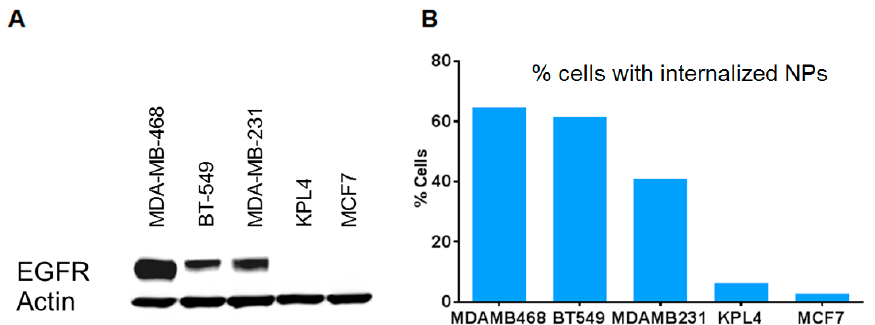
Figure 4. Specific uptake of cetuximab (anti-EGFR)-conjugated nanoparticles to EGFR+ vs. EGFR- breast cancer cells. ( A ) EGFR expression of cells by Western blot analysis. ( B ) Flow cytometry analysis of cells taking up dye-tagged nanoparticles after 1 hr of contact time.